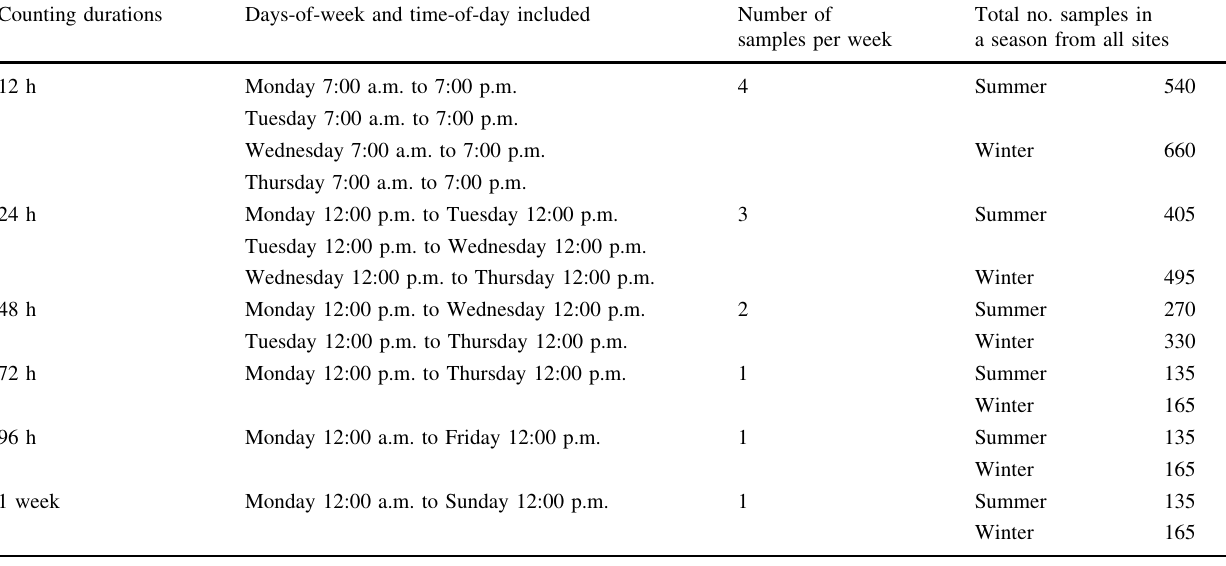
Table 2 Details of sample data of short-period counts studied Counting durations Days-of-week and time-of-day included Number of